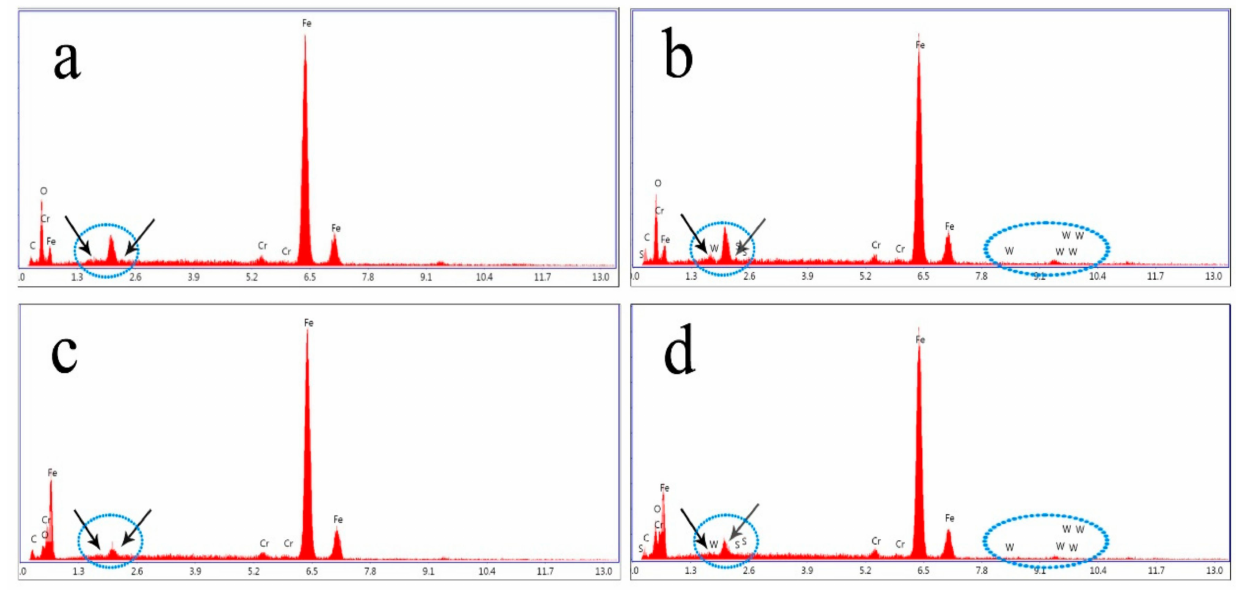
Figure 9. EDS profiles of the surface after friction process samples, under ( a ) pristine PAO6 oil and ( b ) PAO6 containing 0.25 wt% IF–WS 2 at 100 ◦ C; and ( c ) pristine PAO6 oil and ( d ) PAO6 containing 0.25 wt% IF–WS 2 particles at 75 ◦